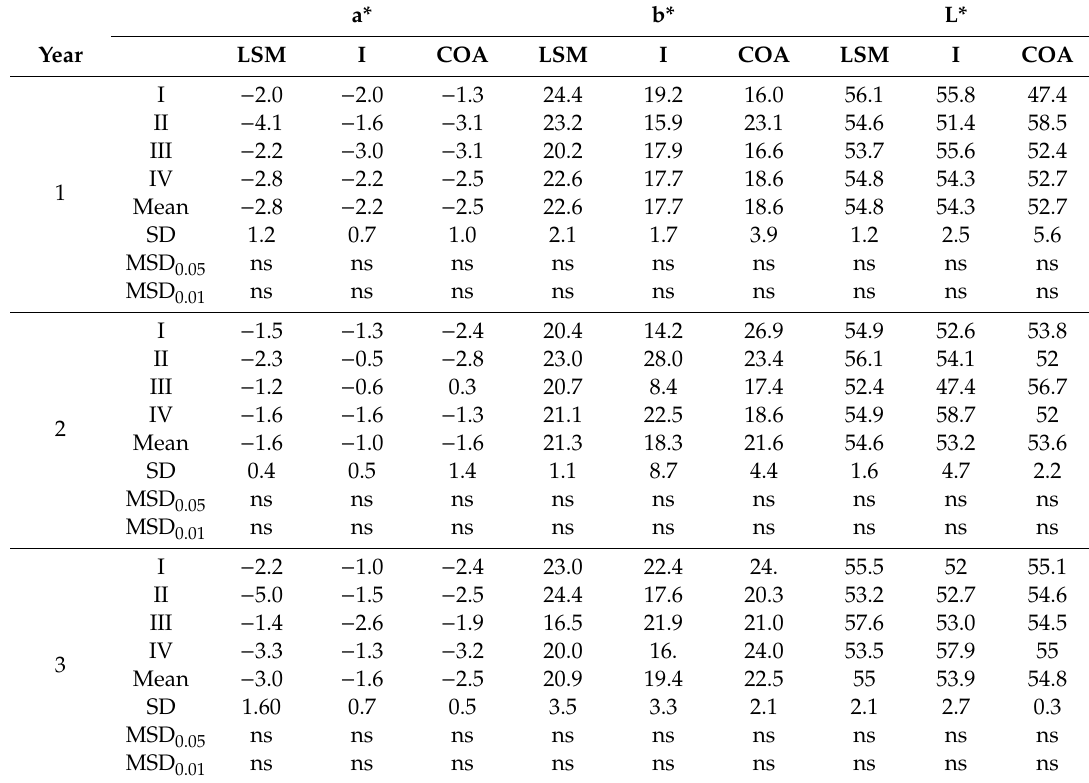
Table 5. Color (a*, b*, L*) changes during the development of three celery crops grown in the field, as a function of the fertilization treatment: local sheep manure (LSM), mineral (I), and commercial organic amendment